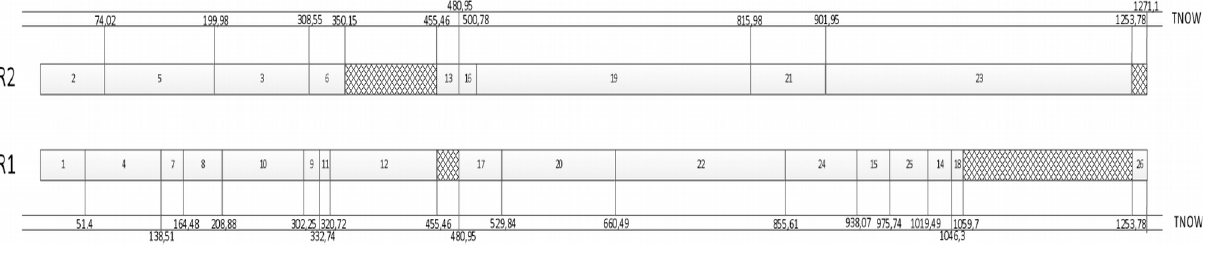
Figure 8. Gantt Chart for the ACTIM Scheduling (Scenario